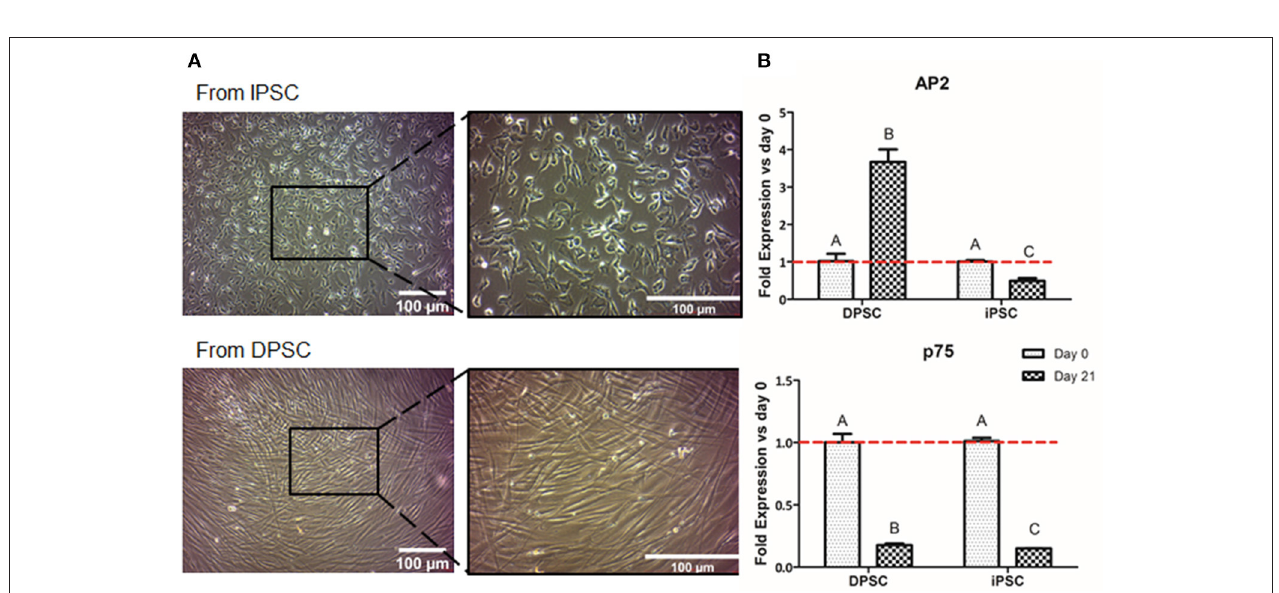
FIGURE 2 | Cell reprogramming from DPSC and fibroblasts. Relative mRNA expression in DPSC and fibroblasts (positive control), before and after cell reprogramming (A) . Pluripotent expression of Oct 4 and Nanog by quantitative RT-PCR. Optical microscope images of iPSC colonies cultured in VTN-coated dishes from fibroblasts (positive control) and from DPSC (B) . *Scale bars: 200 µ m (lower magnification) and 100 µ m (higher magnification). **Data presented are means ± SD, n = 3 technical replicates per donor and experimental group. Different letter denotes significant differences ( p < 0.05). Same letter denotes non-significant differences.